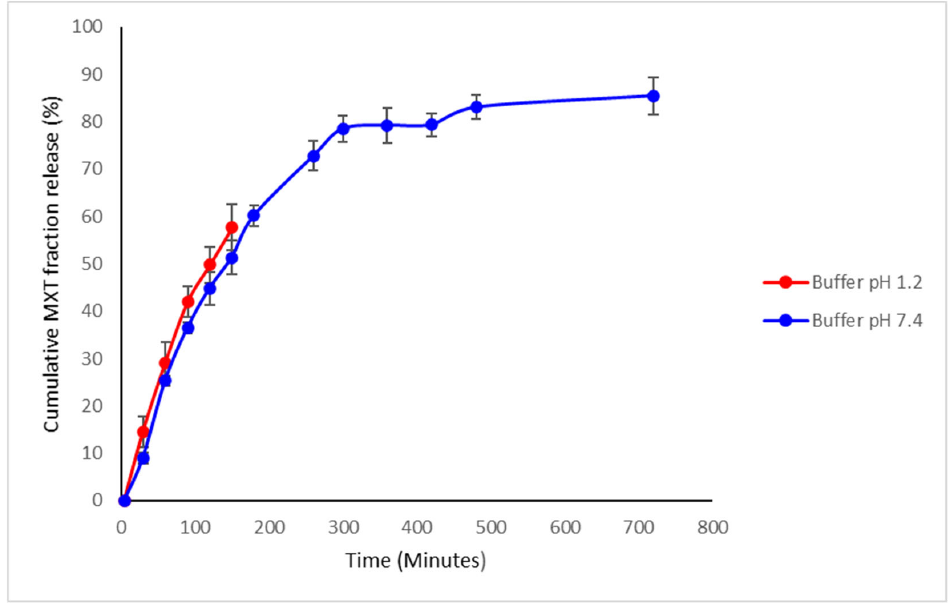
Figure 8. In vitro release of MTX from TPGS-PLGA nanoparticles at a stomach acidity of pH 1.2 and intestinal environment of pH 7.4 ( n = 3, mean ± SD).